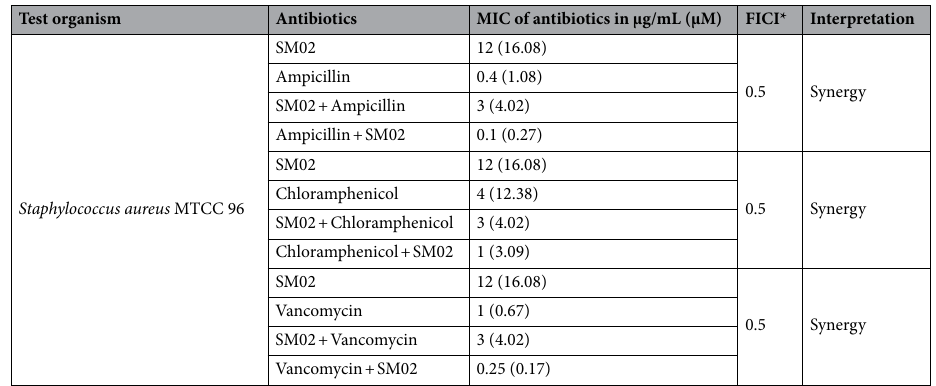
Table 3. Synergistic relationship of pyrimidomycin with highly used popular antibiotics like ampicillin, chloramphenicol, vancomycin. *Fractional inhibitory concentration index (FICI) = (MIC of drug A in combination/MIC of drug A alone) + (MIC of drug B in combination/MIC of drug B alone). FICIs were interpreted as follows: ≤ 0.5 = synergy; 0.5–0.75 = partial synergy; 0.76–1.0 = additive effect; 1.0– 4.0 = indifference; and > 4.0 =